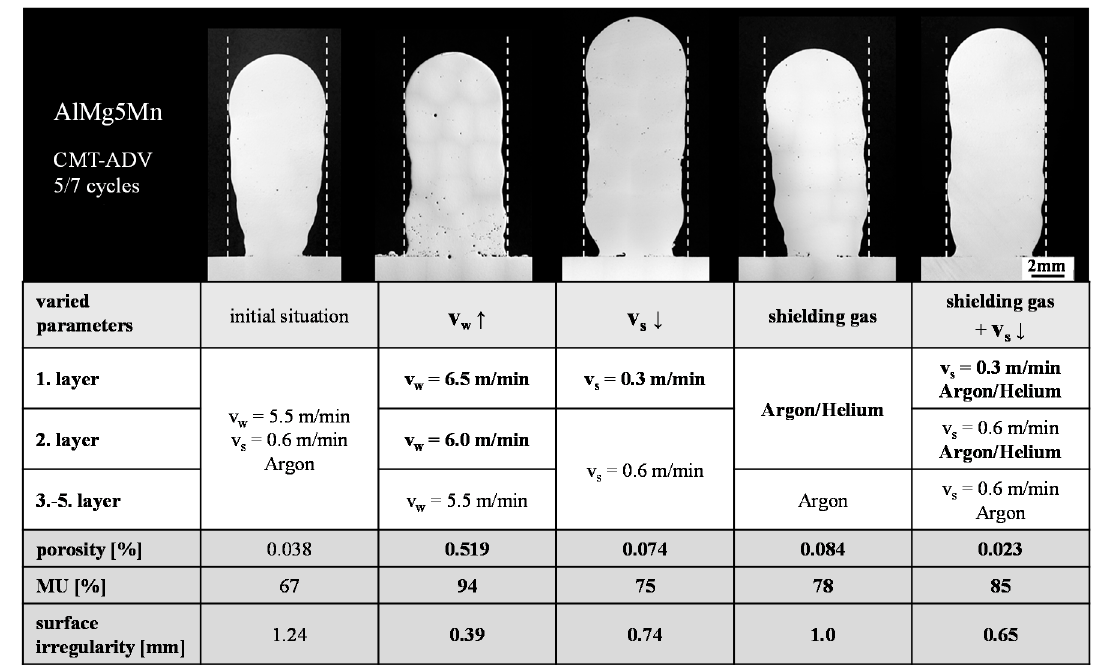
Figure 10. Comparison of the different strategies to increase the final contour accuracy (represented by material utilization (MU) and surface irregularity) of the CMT-ADV arc mode with a cycle constellation of 5/7.